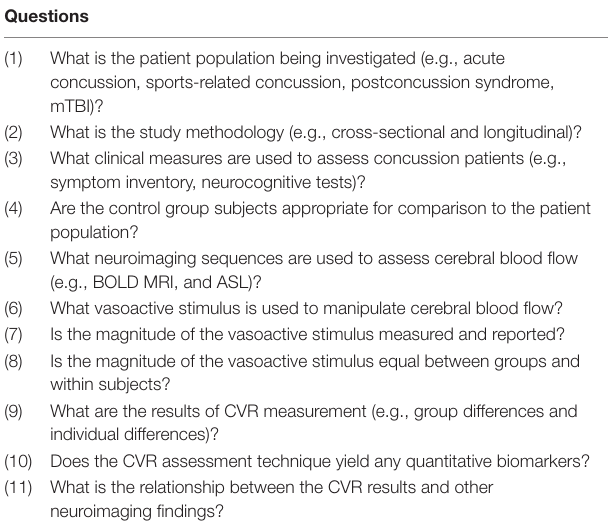
taBLe 2 | Methodological framework for evaluation of cerebrovascular reactivity measurement in